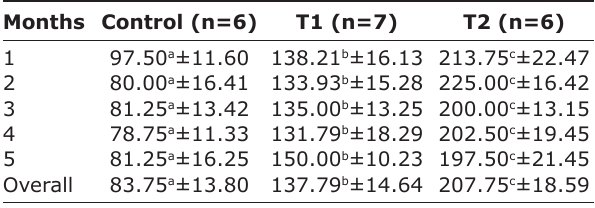
Table-2: LSQ mean±SE of MBRT (min) for milk quality test at tropical lower Gangetic